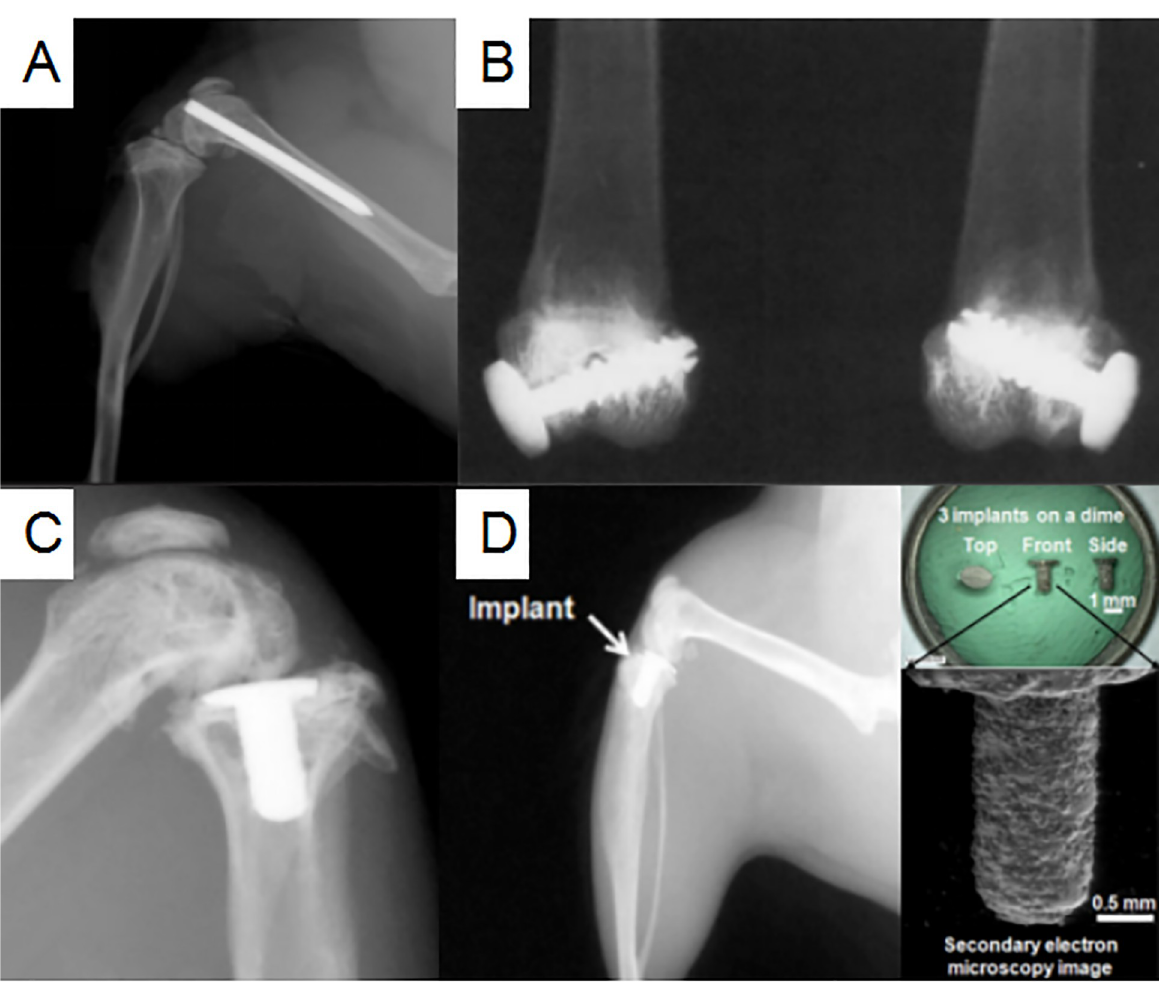
condyle and anterior to the lateral collateral ligament of a rabbit model [16]. ( C) A 3-dimensionally printed Ti-6Al-4V prosthesis implanted in the tibial plateau of a mouse model [15].( D) A 3-dimensional printed prosthesis implanted in the tibia of a murine model